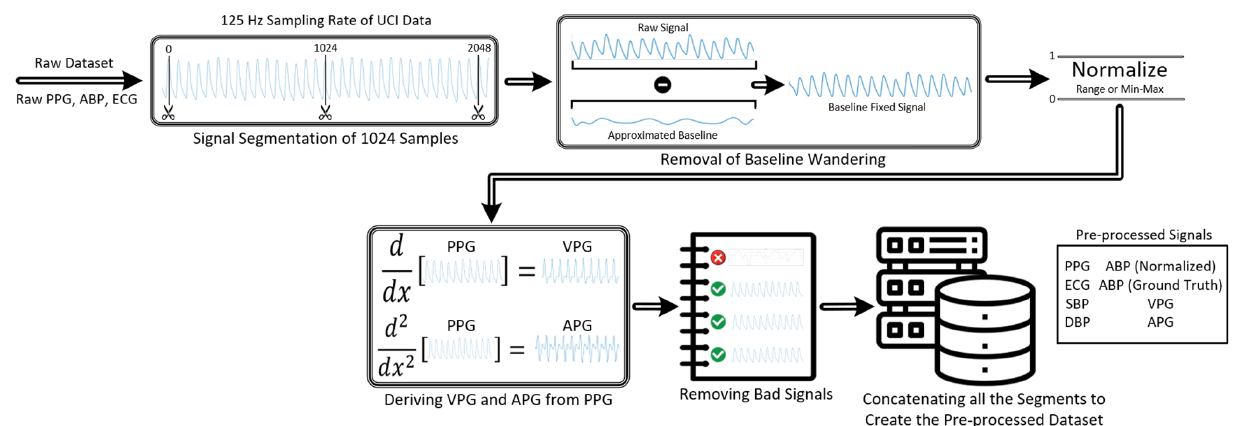
Figure 1. Flowchart representing the data pre-processing pipeline for the UCI Dataset. The pipeline for the Ballistocardiogram (BCG) Dataset is almost identical except the ABP signals were denormal- ized first by multiplying with the normalizing factor of 100.